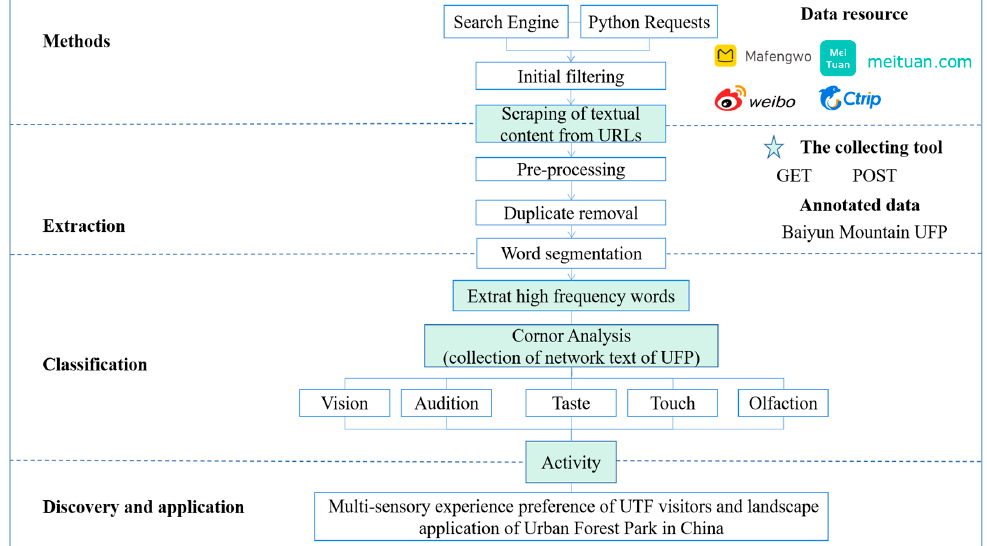
Figure 4. Research framework.